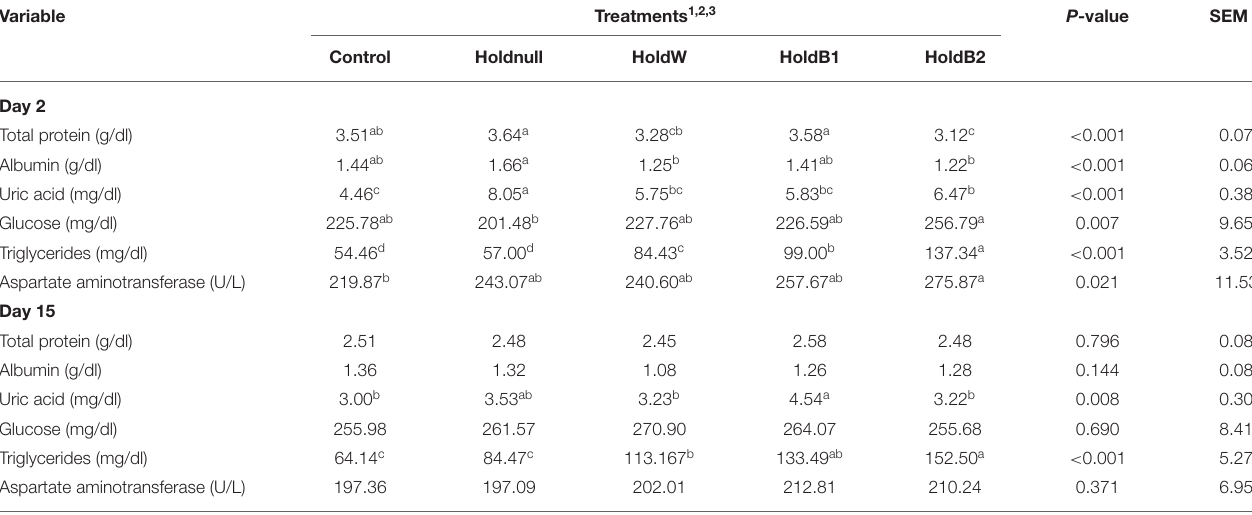
TABLE 4 | Effect of betaine supplementation in drinking water on selected blood biochemical parameters of broiler chicks held 48h post-hatch.